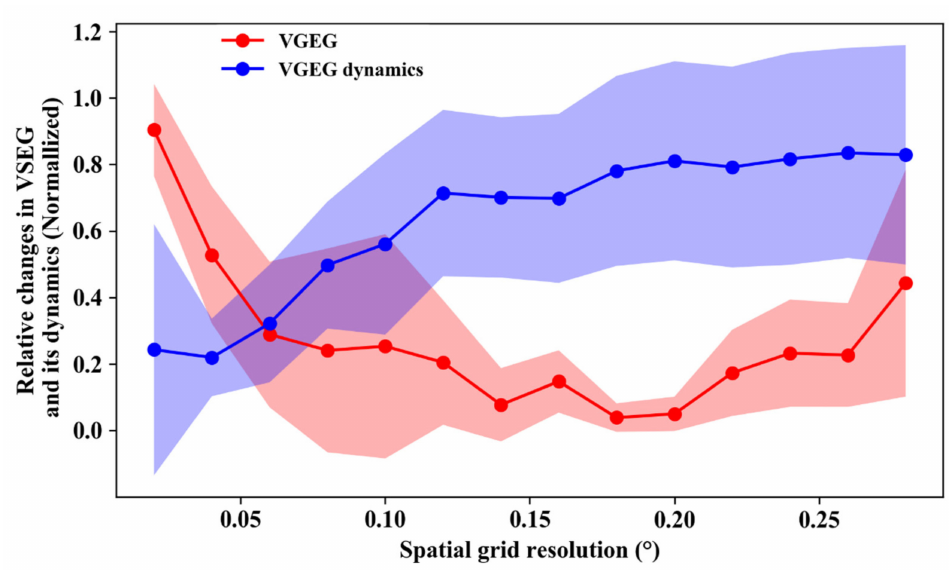
Figure A3. Effect of the spatial resolution on the VGEG (Vegetation Greenness along the Elevation Gradient) and its dynamics. The shadow region denotes 1 standard deviation. The Min-Max Normalization method is used to constrain the data between 0 to 1.